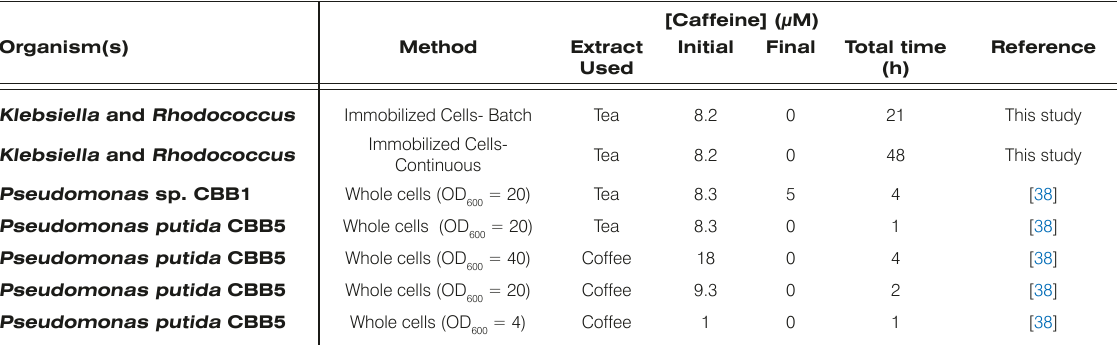
Table 2. Comparison of decaffeination of coffee or tea extracts by various